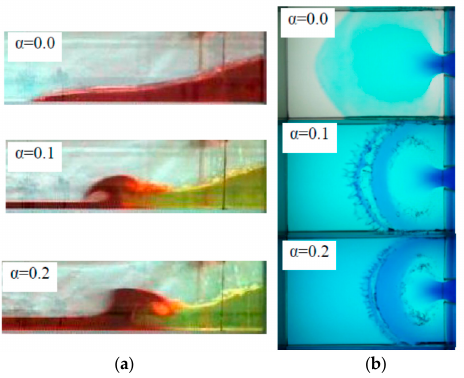
Figure 5. Dam-break wave propagation for all tests at t = 0.4 s: ( a ) 2D experiments [22,52] and ( b ) 3D experiments.